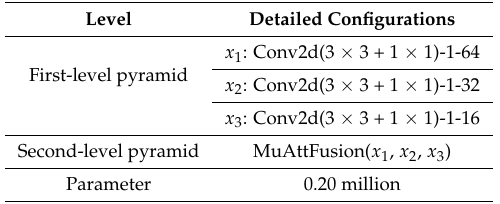
Table 3. Two-level spectral feature fusion pyramid configurations. The module parameters are denoted as “module name(receptive fields)-number of modules-number of module output